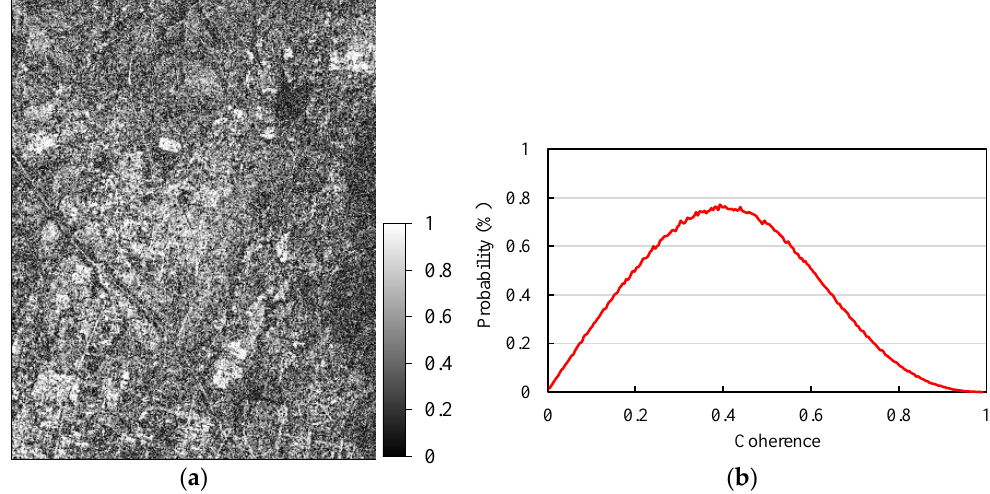
Figure 4. Coherence analysis of the flattened interferogram with ( a ) coherence map and ( b ) coherence probability histogram.